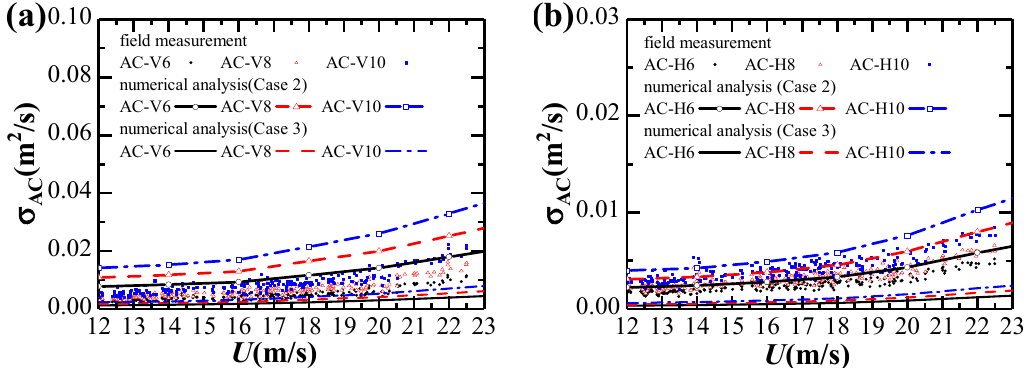
Figure 14. Comparison of standard deviations of acceleration response obtained by field measurements and numerical analysis in Case 2 and Case 3: ( a ) Vertical; ( b ) Horizontal.